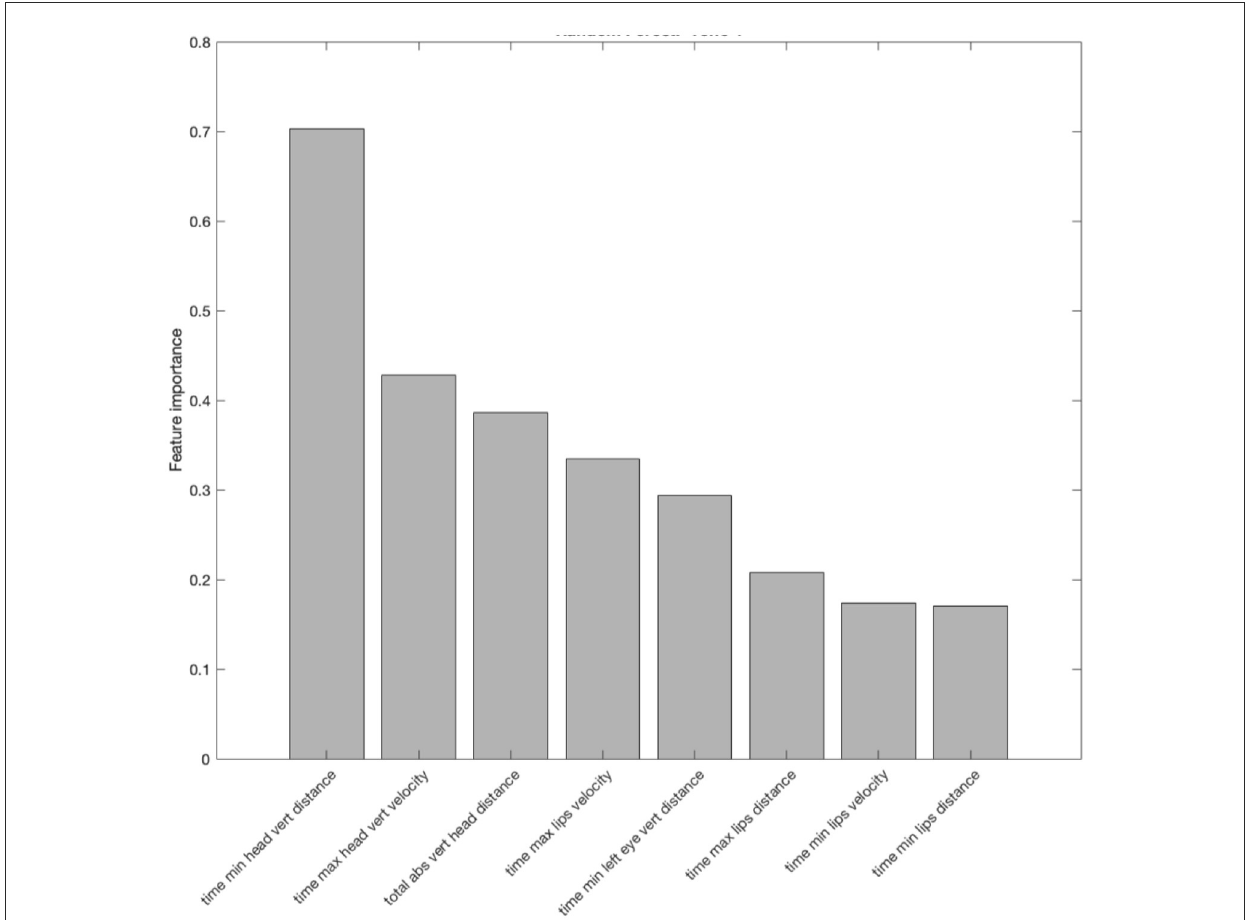
FIGURE10 Important features identified by random forest in differentiating the two speech styles (clear and plain) in Tone 4. The y-axis shows the feature importance measured by the random forest. The feature importance measures the increase in classification error if the values of the feature are permuted. The greater the error the higher the importance of the feature